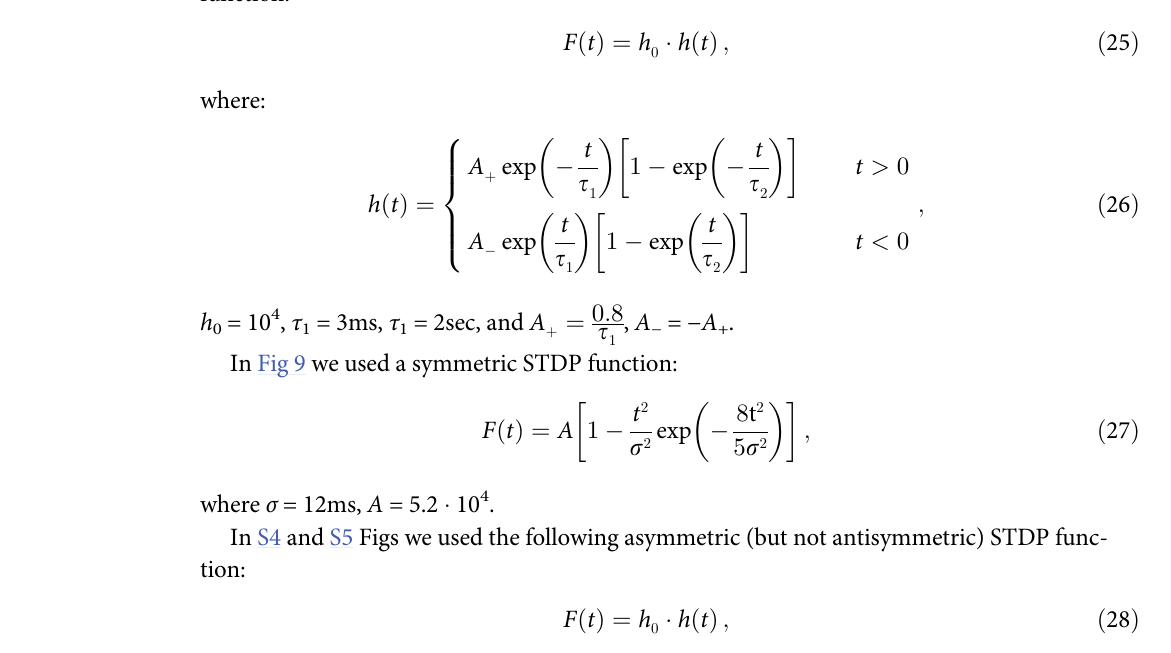
where τ = 5ms, τ = 1s, and d is the synaptic latency. The coef fi cient a R 1 2 1 current such that spike in a pre synaptic neuron j increases (or decreases), on average, the number of spikes emit- ted by the post synaptic neuron i by one.